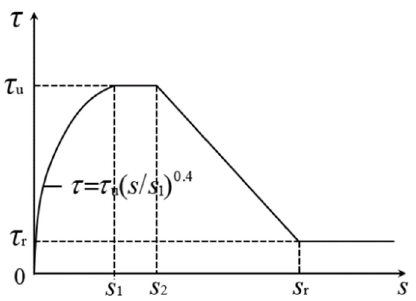
Figure 10. Bond stress-slip curve in Fib Model Code 2010.